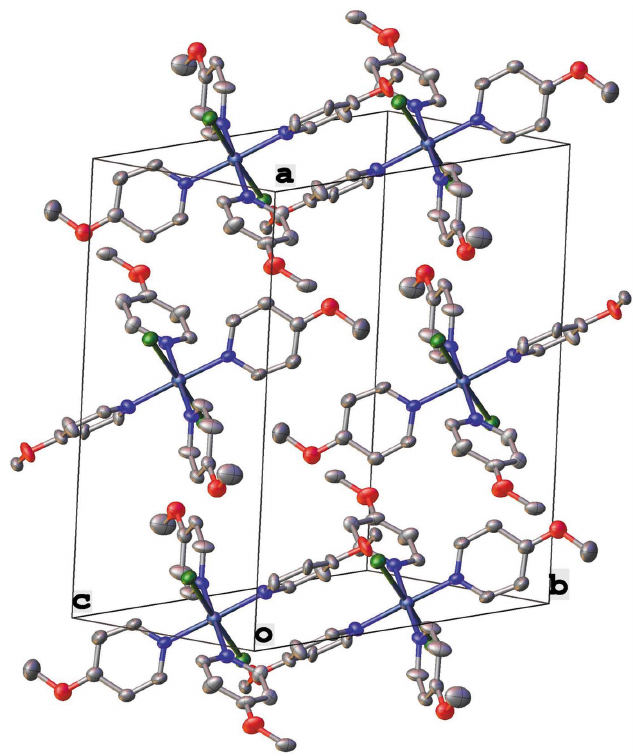
Figure 2 Projection of 1 onto the (111) plane. Anisotropic displacement ellipsoids have been set to the 50% probability level. Additional conformations of the molecule generated via the disorder around 4 as well as the hydrogen atoms have been removed for the sake of clarity.